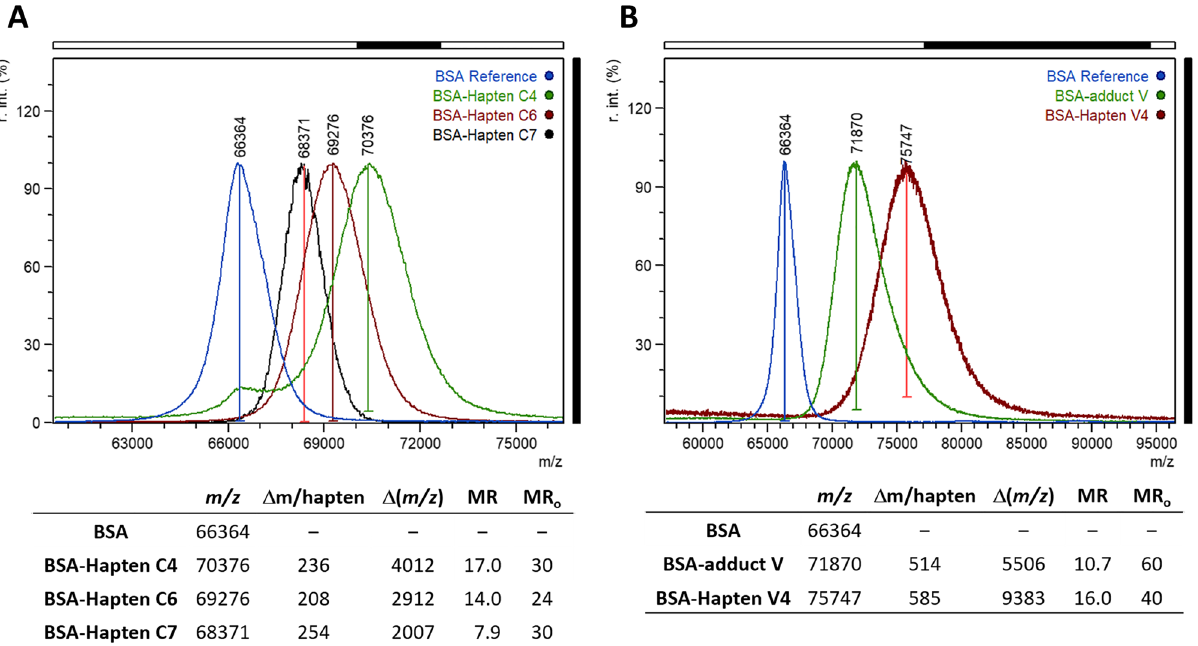
Figure 4. ( A ) MALDI-TOF mass spectra (singly charged ions) of BSA (blue) and the corresponding conjugates with haptens C4 (green), C6 (red), and C7 (black). ( B ) MALDI-TOF mass spectra (singly charged ions) of BSA (blue) and the corresponding conjugates with adduct V (green) and hapten V4 (red). Spectrum intensities are normalized. MR o and MR are the initial and final hapten-to-protein molar ratios,